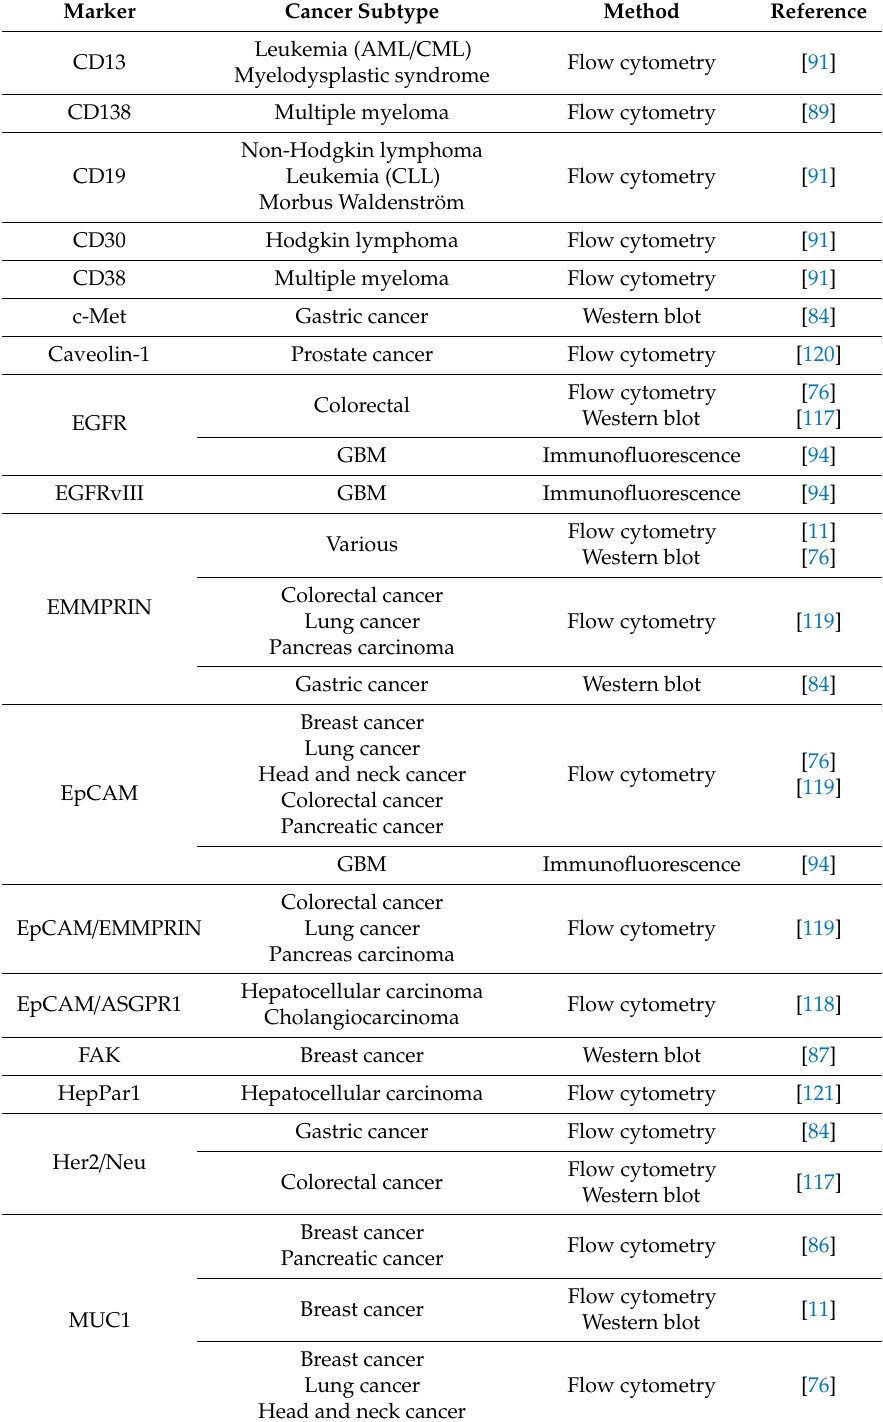
Table 1. Common tumor antigens detected on patient-derived